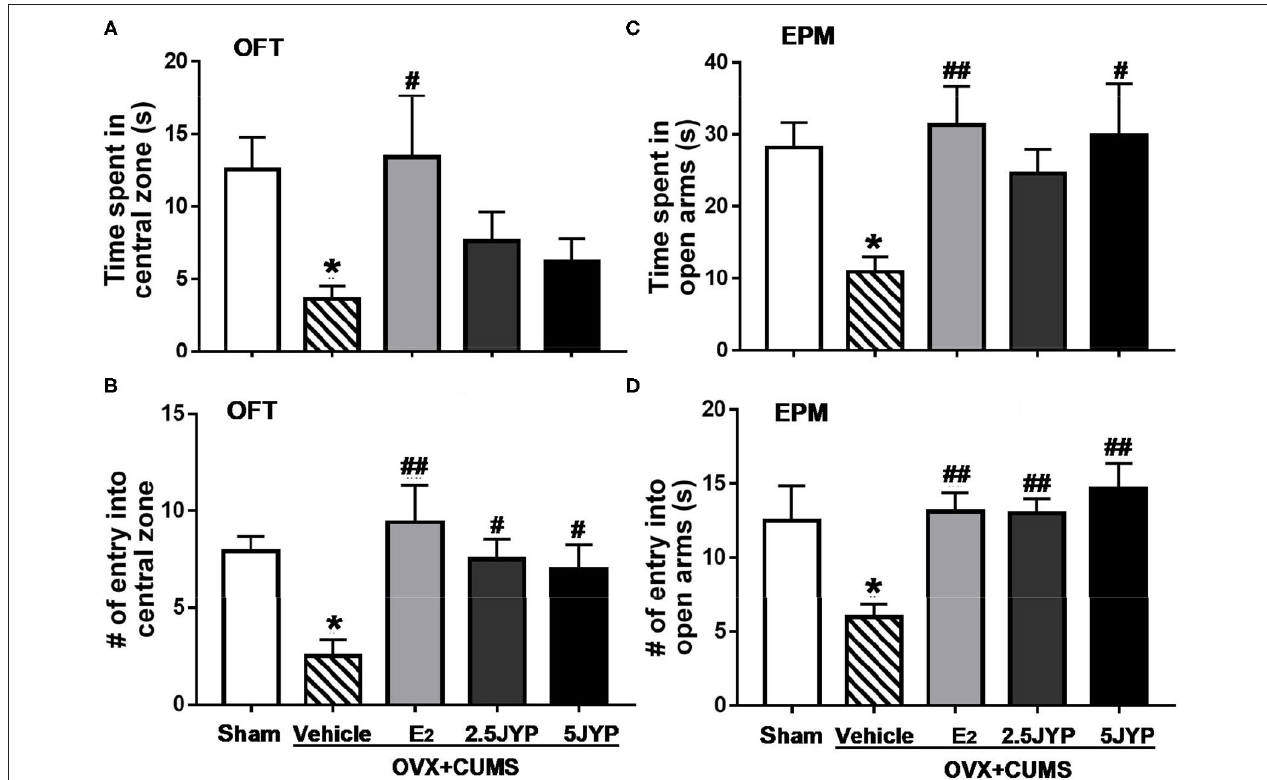
FIGURE 3 | Effects of 2.5 g/kg JYP (2.5 JYP), 5.0 g/kg JYP (5 JYP), and 0.3 mg/kg estradiol (E2) on OVX + CUMS-induced anxiety-like behavior: (A) Duration in the central zone in the open field test (OFT); (B) Number of entries into the central zone in the OFT; (C) Duration in the open arms in the elevated plus maze (EPM) test; and (D) Number of entries into the open arms in EPM. Data are expressed as mean ± SEM ( n = 9–10) and examined with one-way analysis of variance (ANOVA), followed by post hoc between-group comparisons: * P < 0.05 vs. sham group; # P < 0.05, ## P < 0.01 vs. vehicle